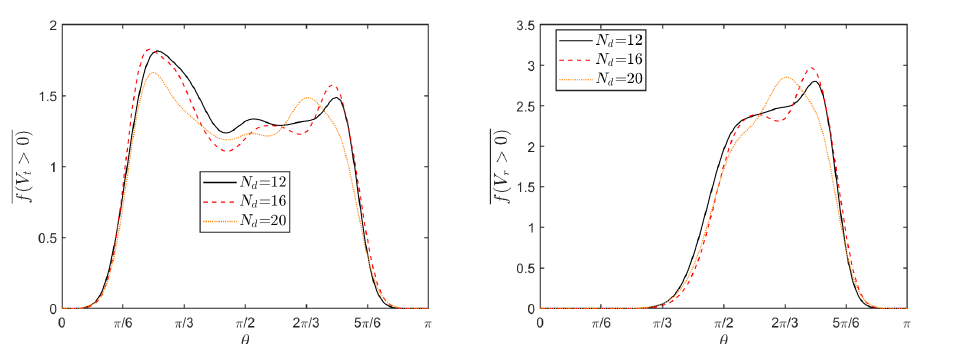
Figure 7. The probability that the relative tangential ( left ) and radial ( right ) velocities of the drops next to the bubble are positive, for Eo b = 2.0 and different numbers of